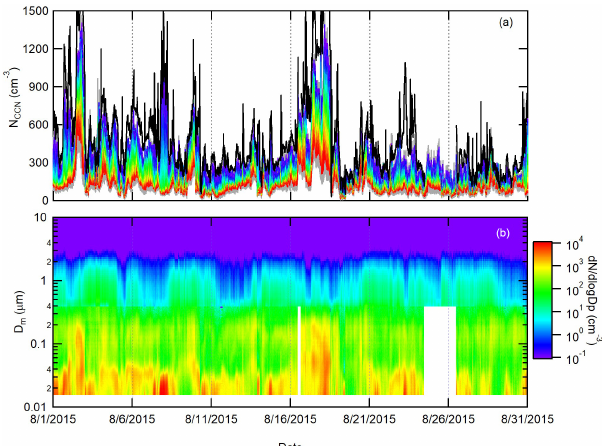
Figure 1. Time series for the month of August 2015 at Mace Head, Ireland, of ground-based CCN concentrations (a) and merged SMPS and APS number size distributions (b)